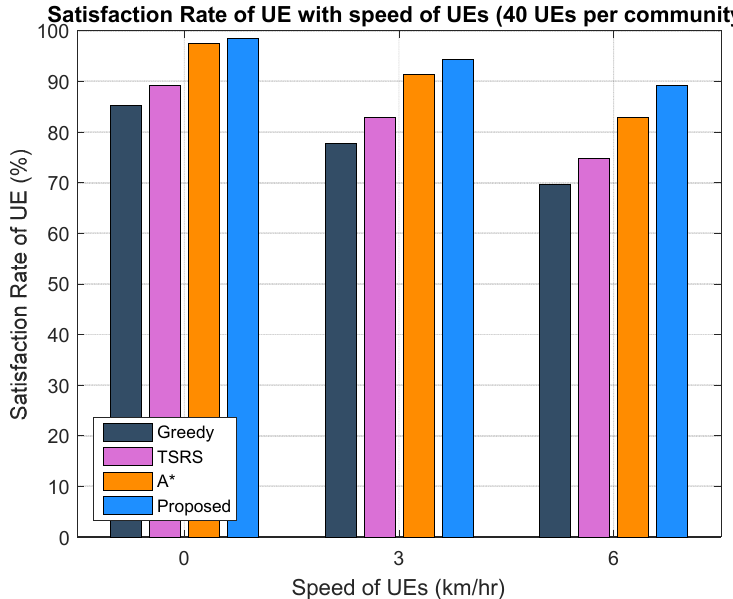
Figure 20. Satisfaction rates vs. UE’s moving speed.